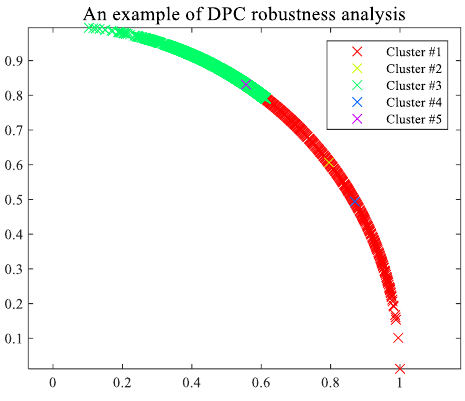
Figure 21. Schematic diagram of clustering effect.